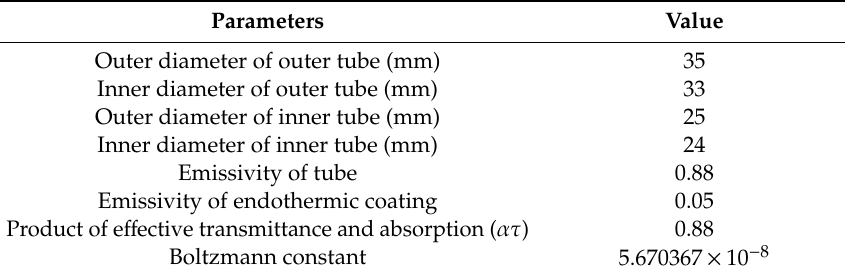
Table 1. The required geometric parameters and constants for theoretical